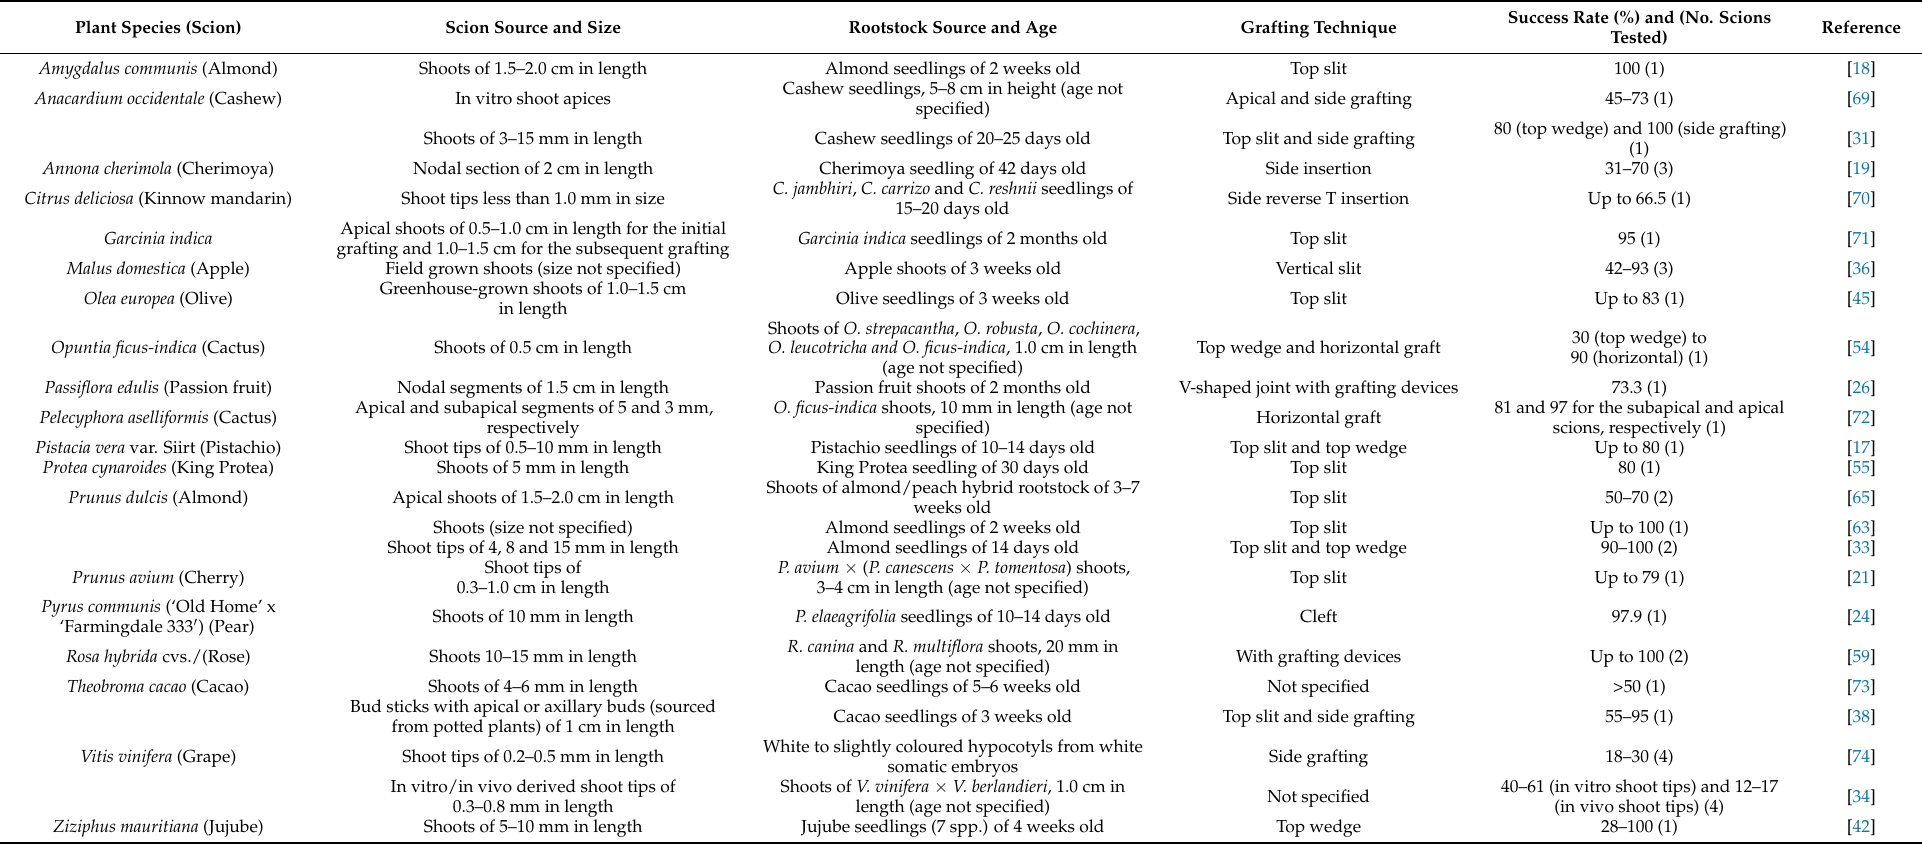
Table 1. Applications of in vitro micrografting for restoration of scion vigor and establishment of plants with